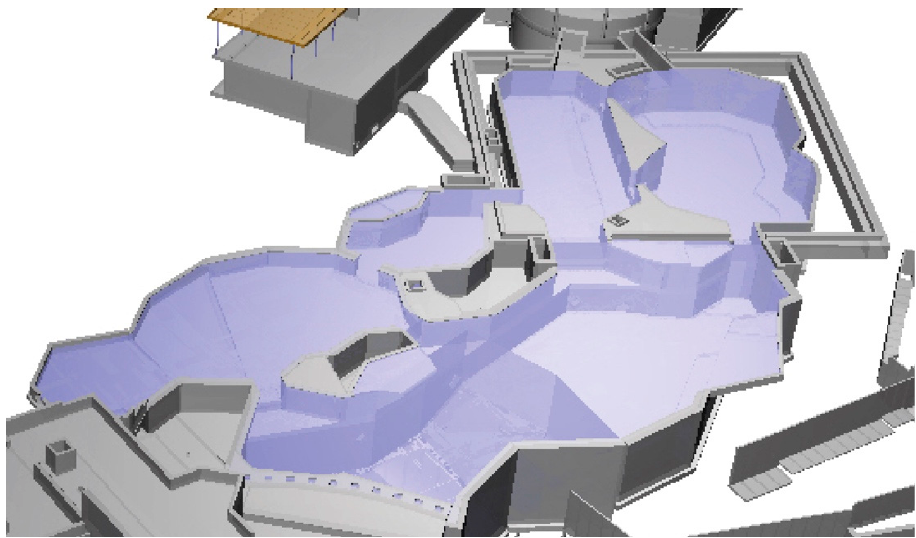
Figure 1. Scheme of the outdoor pools, called the lagoon, where the dolphins were